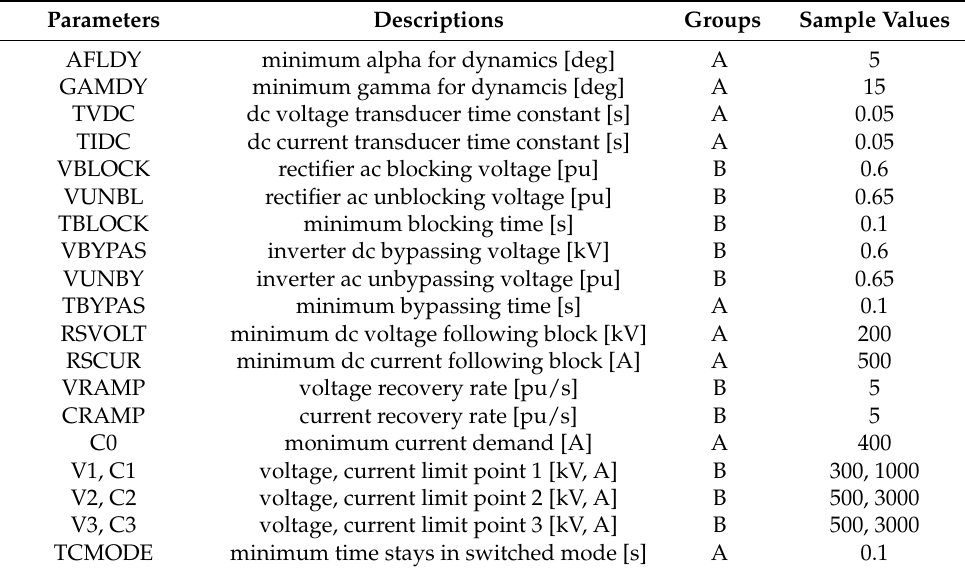
Table 1. Parameters given by manufacturers (Group A) and modified by user (Group B) of CDC4T and